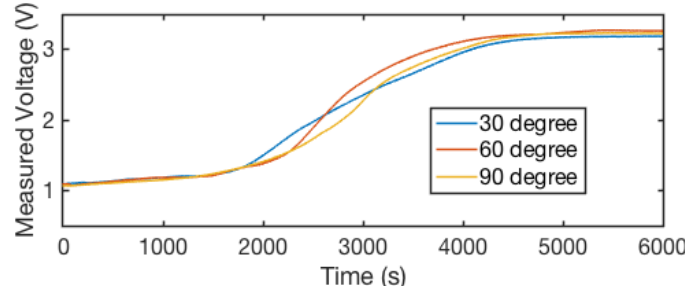
Figure 13. Thread readings during the evaporation process, with a five-point moving average applied. We observed that, under different bending angles, the sensor shows similar profiling through the evaporation process. This indicates that our sensor is robust to bending